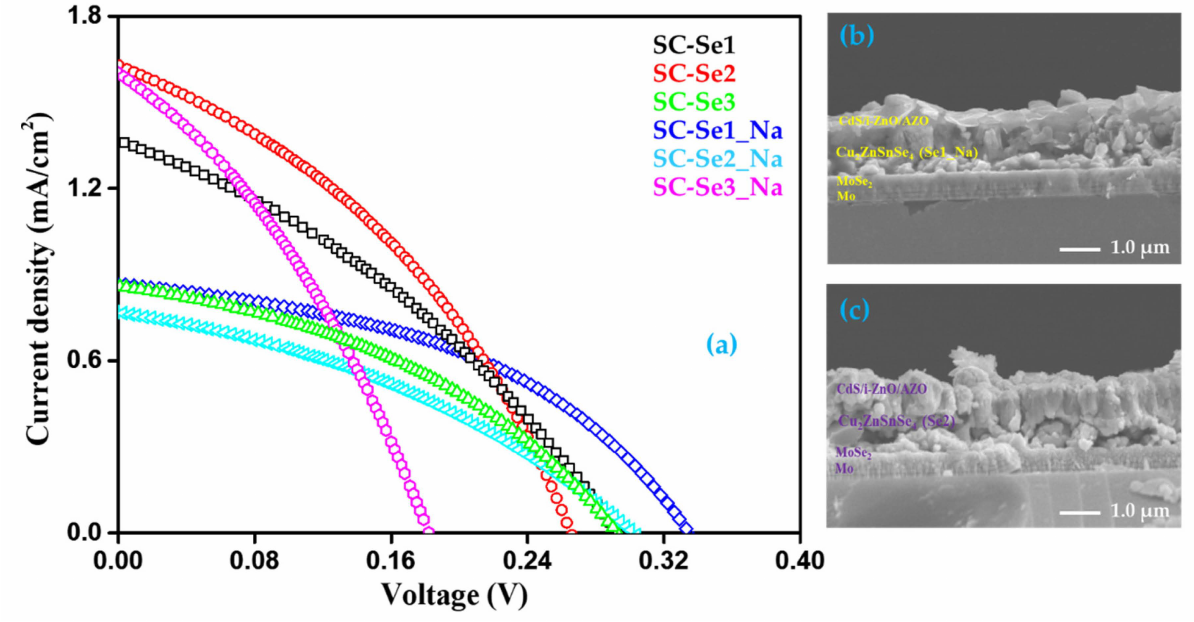
Figure 11. ( a ) J-V curve of CZTSe photovoltaic device under AM 1.5G illumination, and cross-section image of ( b ) Se2 and ( c ) Se1_Na photovoltaic